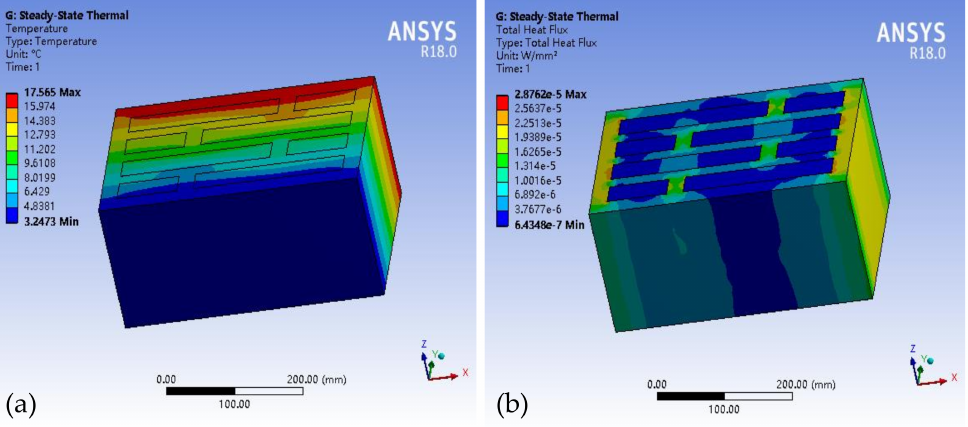
Figure 9. ( a ) Temperature contour plot; ( b ) heat flux contour plot.